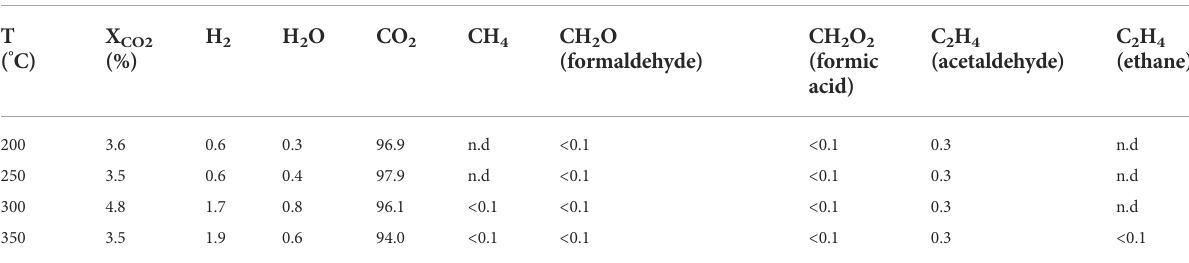
TABLE 1 CO 2 conversion and gas phase composition at different reaction temperatures. Reaction conditions: CO 2 :H 2 O mole ratio = 0.26; reaction time = 4 h; 0.56 g Fe. “ n.d. ” indicates that a species was not detected. Gas phase composition